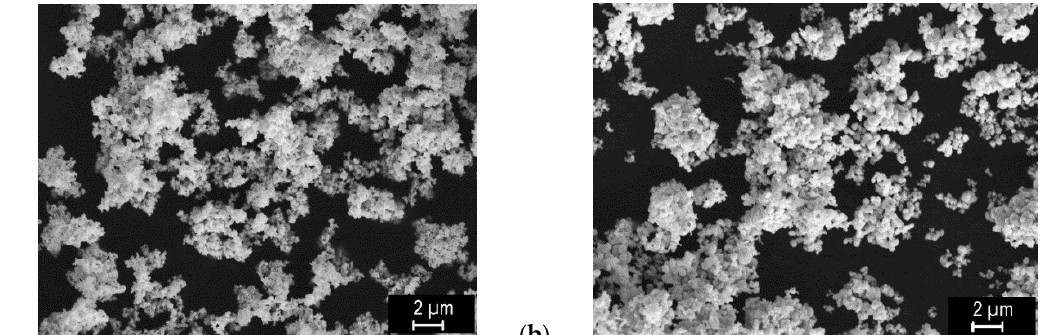
Figure 1. SEM images of the 0.5 µm ( a ) and 0.7 µm ( b ) powders. The powders contain even finer particles with various degrees of agglomeration, thus the nominal sizes are only approximate. Table 1. Overview of the samples and preparation conditions. In the sample labels, the first letter designates the powder state (C = cleaned, U = uncleaned), second letter the sintering temperature (L = low, H = high), third letter the foil type (C = graphite, W = tungsten) and the number at the end the sintering time in minutes. The powder size in this table is a nominal value provided by the manufacturer; the sizes of individual grains varied, as shown in Figure 1.